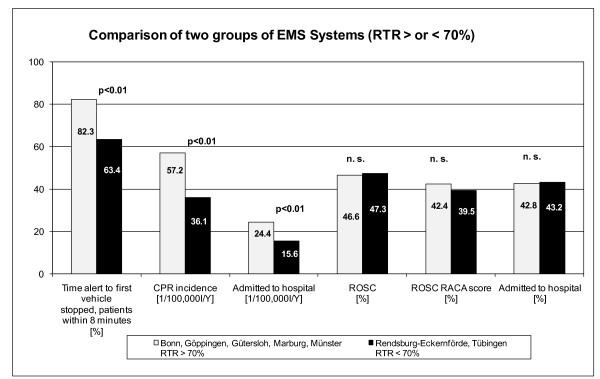
Comparison of two groups of emergency medical service (EMS) systems grouped by response time reliability (RTR) achieved or not achieved in 70% of dispatches. RTR calculates the rate of first vehicle arriving within 8 minutes (%). Response time interval was defined from call reception in the dispatch centre until arrival of the first ambulance on scene and was calculated using the time stamps of dispatch technology. Odds ratios, confidence intervals and χ2 tests were used for statistical analysis. n.s. = not significant; CPR = cardiopulmonary resuscitation; RACA = return of spontaneous circulation after cardiac arrest; ROSC = return of spontaneous circulation.